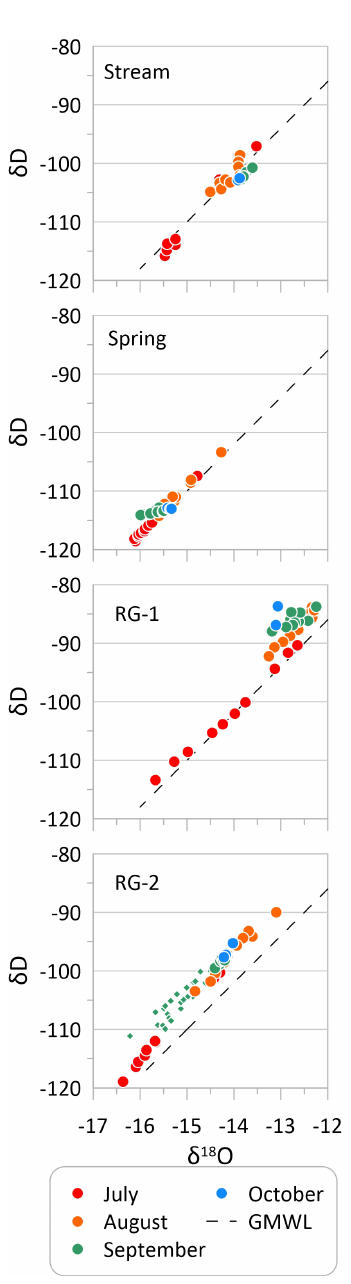
Figure 5. Dual isotope plots for the 4 individual time series. Color- coding represents the month of sample collection. The tendency for samples at the Stream and Spring to remain on the waterline while samples from the rock glaciers deviate to higher values of d -excess in late summer and fall is clearly evident. Green diamonds for RG-2 present reconnaissance data from September 2020.